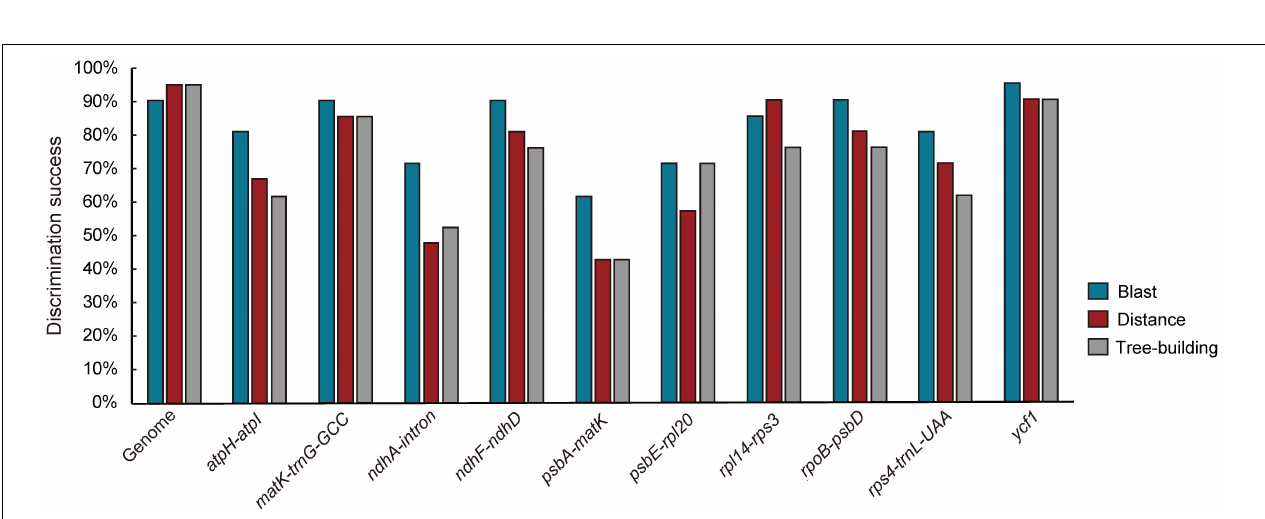
FIGURE 2 | Species discrimination of the complete plastome and 10 high divergence regions (HVRs) for the 21 species in Fritillaria based on the three methods.